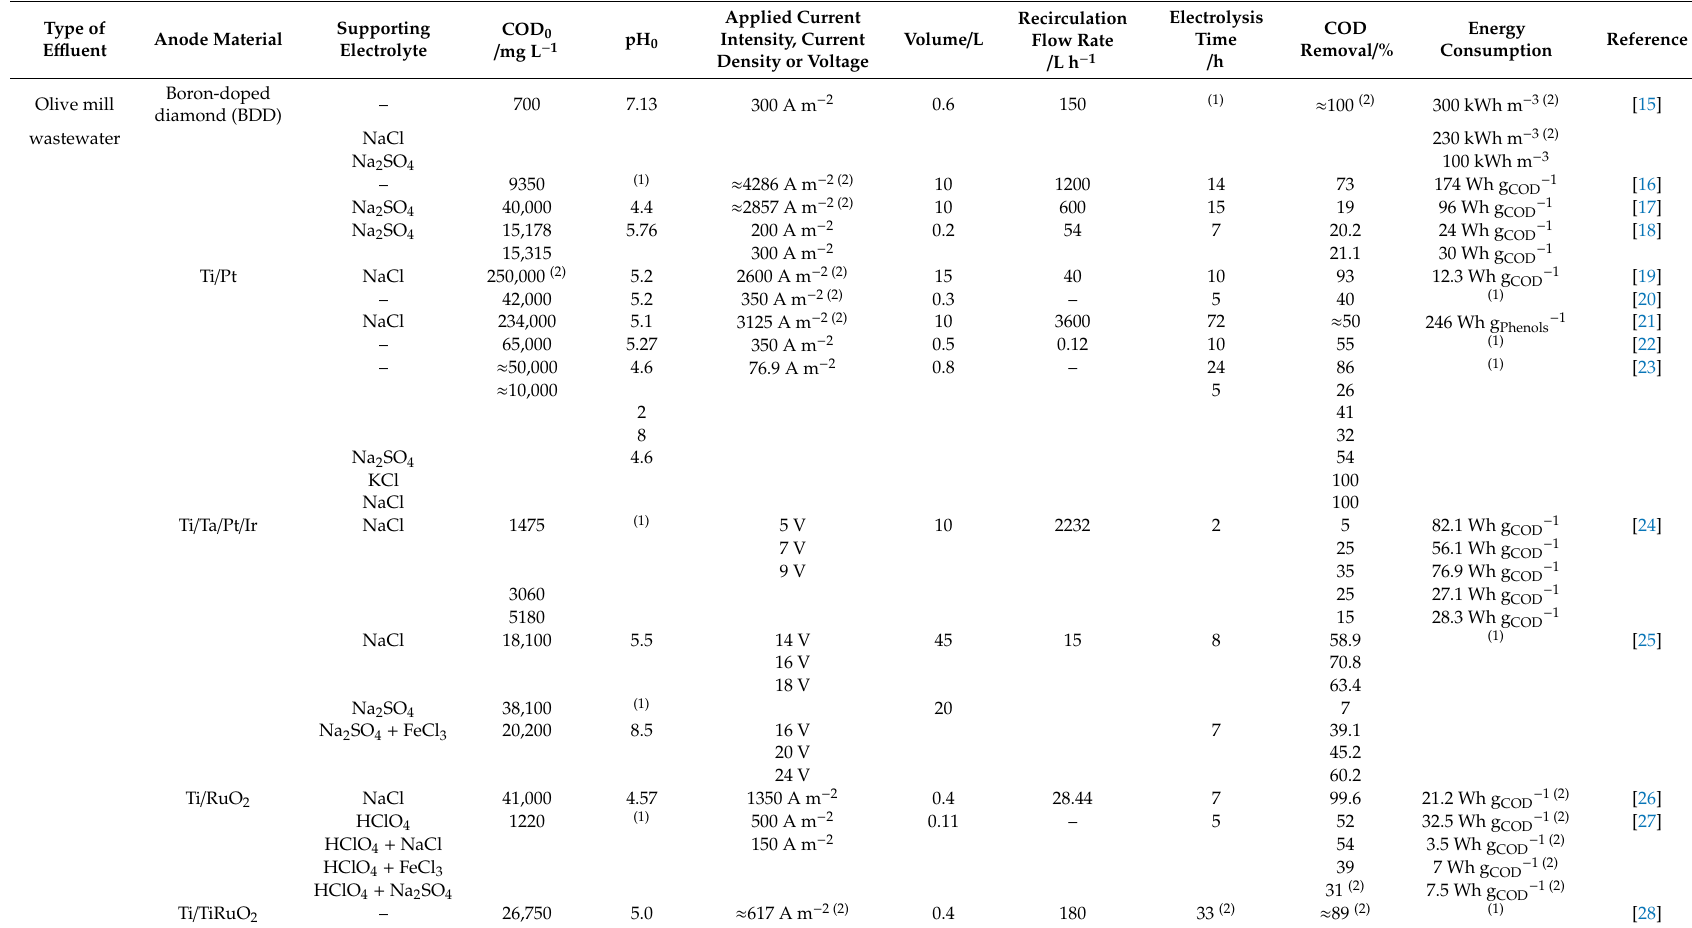
Table 1. A summary of the main research results previously reported for the degradation of e ffl uents from food processing industries by electrochemical oxidation. Type of E ffl